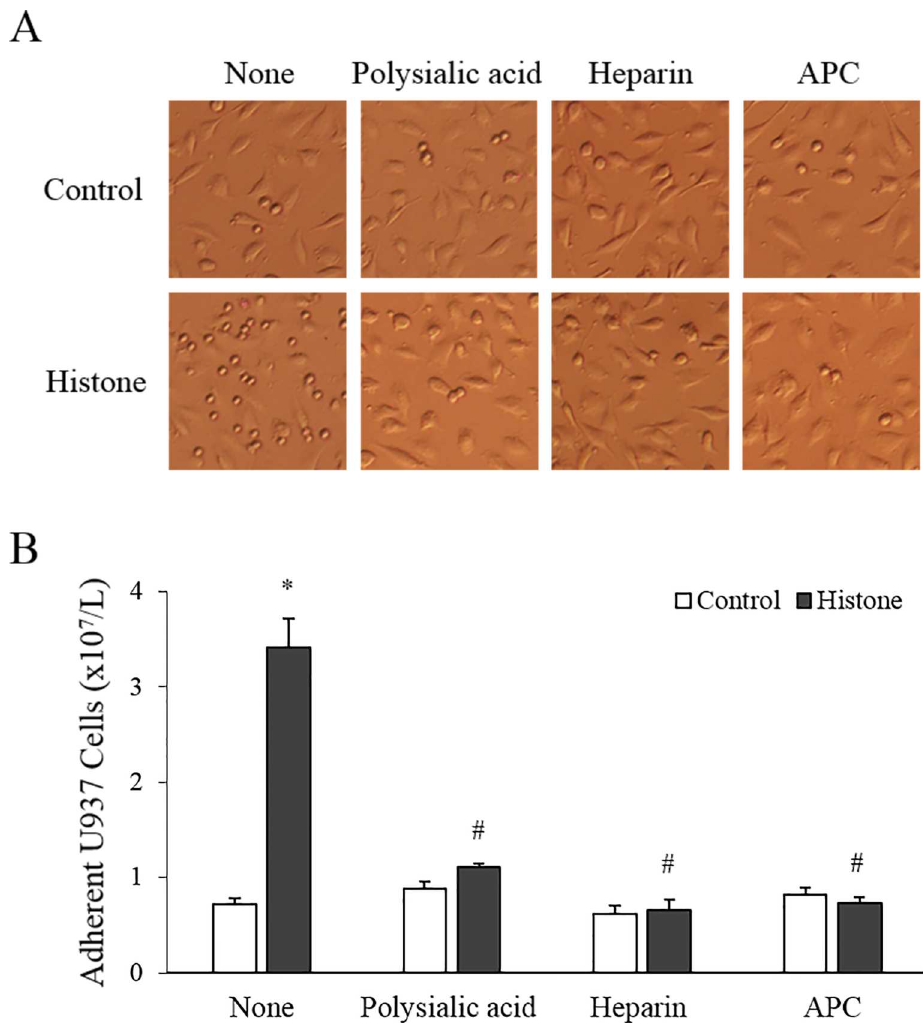
Fig 4. Histone increasesleukemic cell adhesion to endothelial cells (EA.hy926; hEC). (A) Calf thymus histone (50 μ g/mL) was pre-mixed with 62.5 μ g/mL polysialicacid, 100 U/mL heparin, or 100 nM activated protein C (APC) for 1 h, 10 min, and 30 min, respectively, and then added to hEC for 5 h. Then, U937 cells were added onto histone-treated or untreated hEC layers for 30 min. After washing, the adherent small round U937 cells on hEC layers were counted under a microscope (per × 100 field). (B) The numbers of adherent U937 cells are shown as mean ± SEM of 4 experiments. * P < 0.05 versus control; # P < 0.05 versus histone-